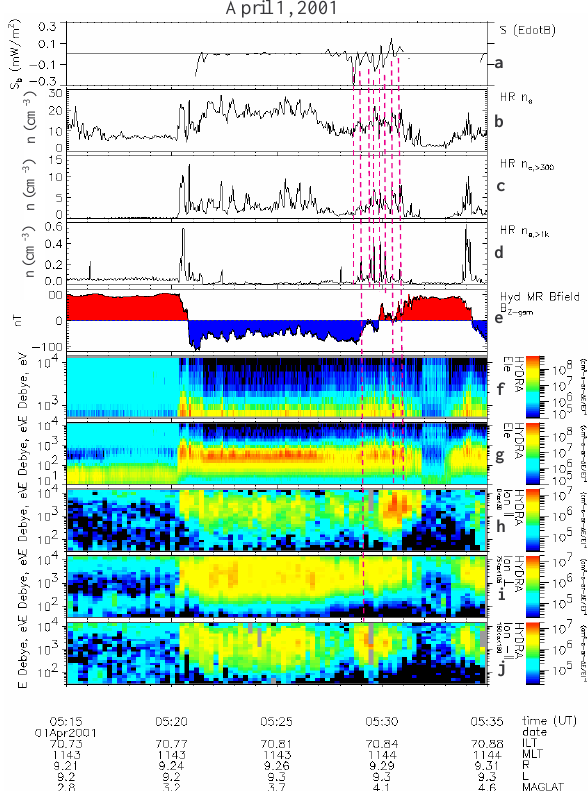
Fig. 13. Polar data acquired during three magnetopause crossings on 1 April 2001. From top to bottom the panels show ( a ) paral- lel Poynting flux, ( b ) electron number density, ( c ) number density of electrons with energies > 300eV, ( d ) electron number density with energies above 1keV, ( e ) northward component of the mag- netic field measured at Polar, ( f ) and ( g ) spectrograms showing electrons with energies > 500eV and the fluxes over the whole in- strument range, ( h ) , ( i ) , and ( j ) ion spectrograms showing the paral- lel, perpendicular and antiparallel fluxes. Accelerated ions, parallel Poynting flux and a high-energy tail on the electron distributions are seen on both sides of the magnetic field reversal in the central crossing. KeV electrons are seen on the magnetosphere side, espe- cially at the other two magnetopause crossings. Poynting flux is not calculated because of the lack of knowledge concerning the correct background level for B in the presence of the field reversal. Vertical lines highlight the correlation between the electron peaks, Poynting flux and accelerated